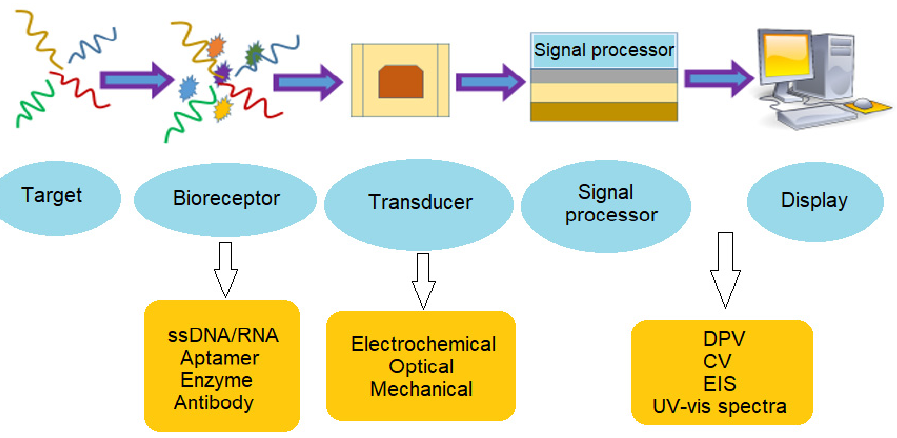
Figure 7. Schematic diagram of biosensor functionality.